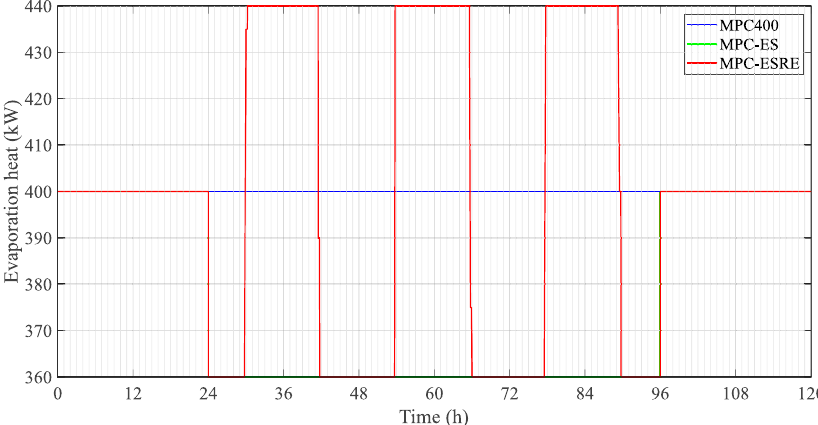
Figure 11. Evaporation heat of the multi-objective case study with the different MPC